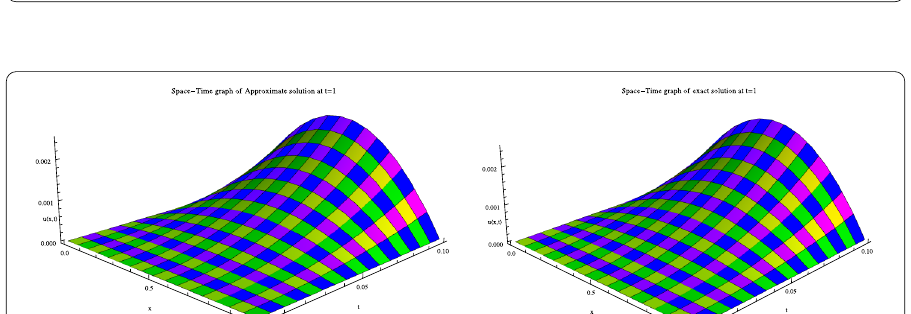
Figure 6 Error profiles for Example 2 at different time levels when N = 60, (cid:2) t = 0.01.